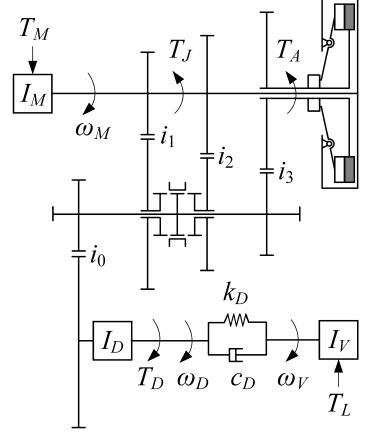
Figure 4. Dynamic model of the drive